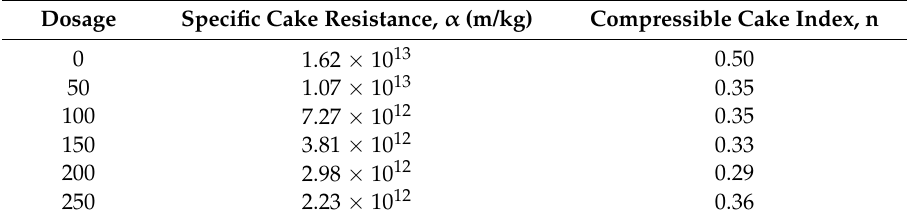
Table 3. Specific cake resistance and compressible cake index with PaCl